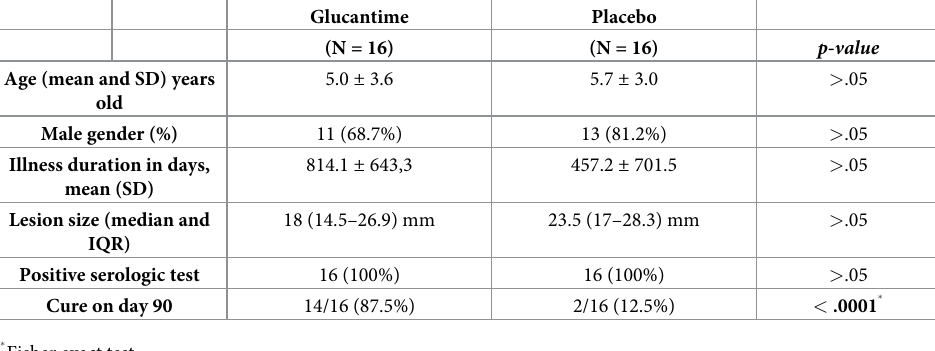
Table 1. Demographic Features, Clinical Characteristics and Response to Treatment of Dogs with Canine Tegu- mentary Leishmaniasis in the Groups Treated with Meglumine Antimoniate or with 0.9% NaCl (placebo).